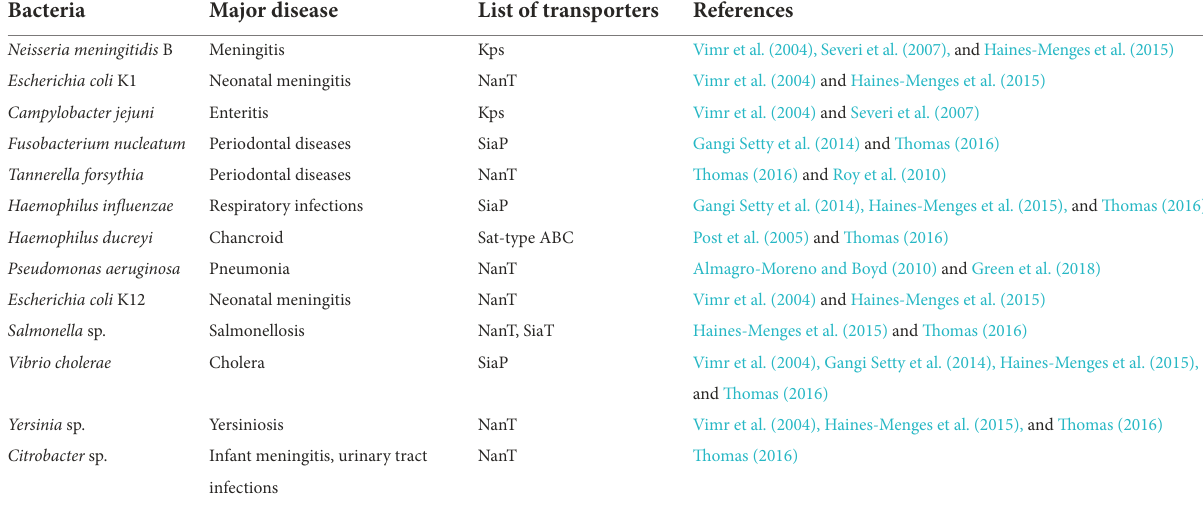
TABLE 1 Examples of bacteria with sialic acid present on their cell